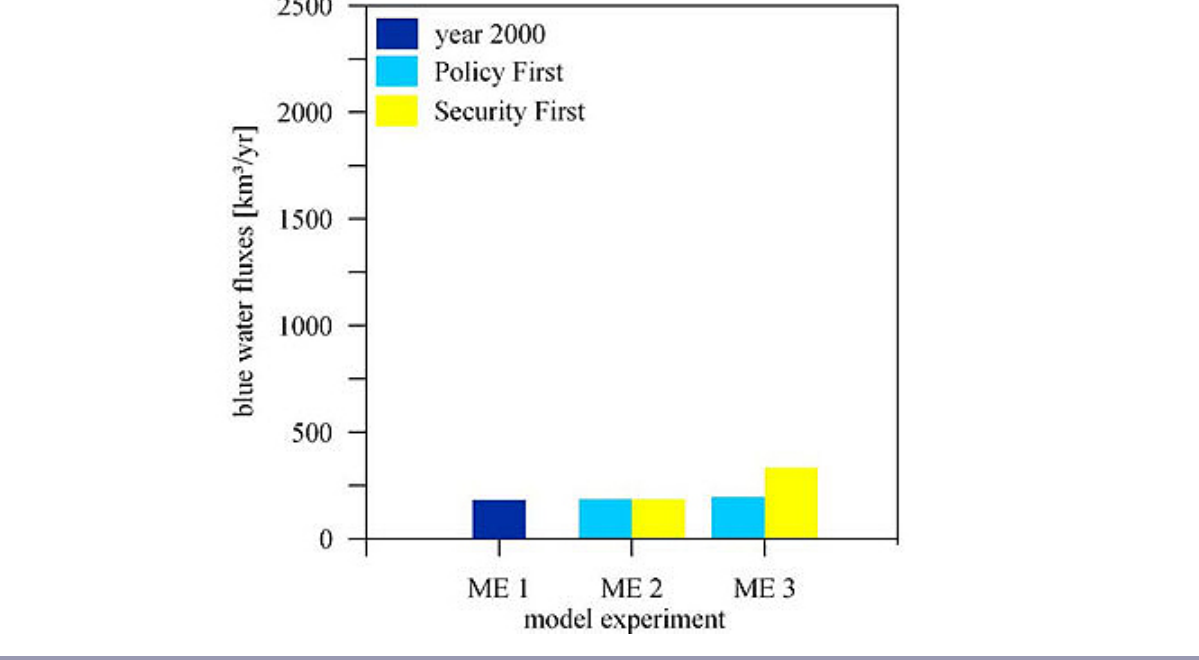
Figure 5. Continental crop-related part of blue water fluxes (irrigation withdrawals). (For a description of the model experiments, see